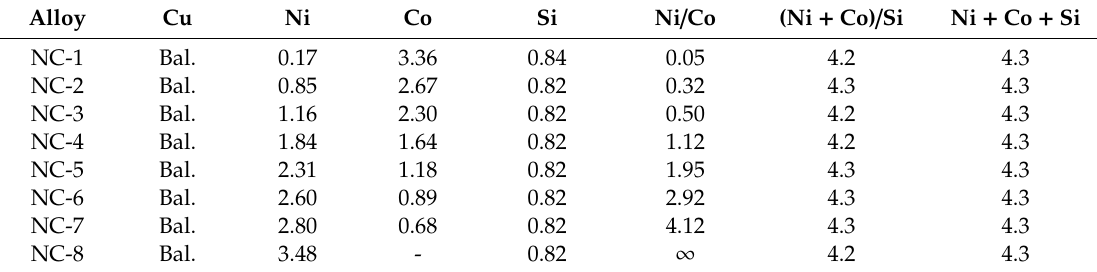
Table 1. Designed and tested chemical compositions of Cu-Ni-Co-Si alloys, wt.%.